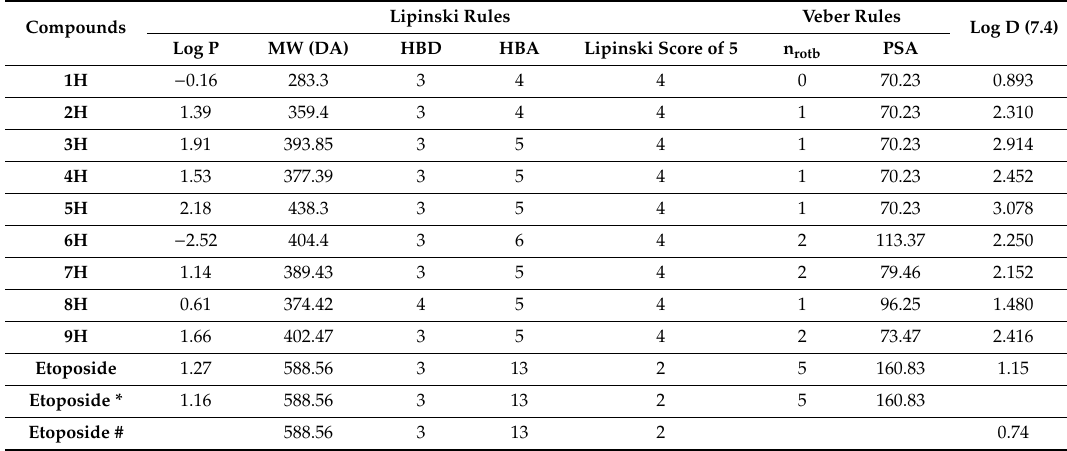
Table 8. Pharmacological activities and properties using Multi Parameter Optimization (MPO) method for the nine TUDHIPP derivatives